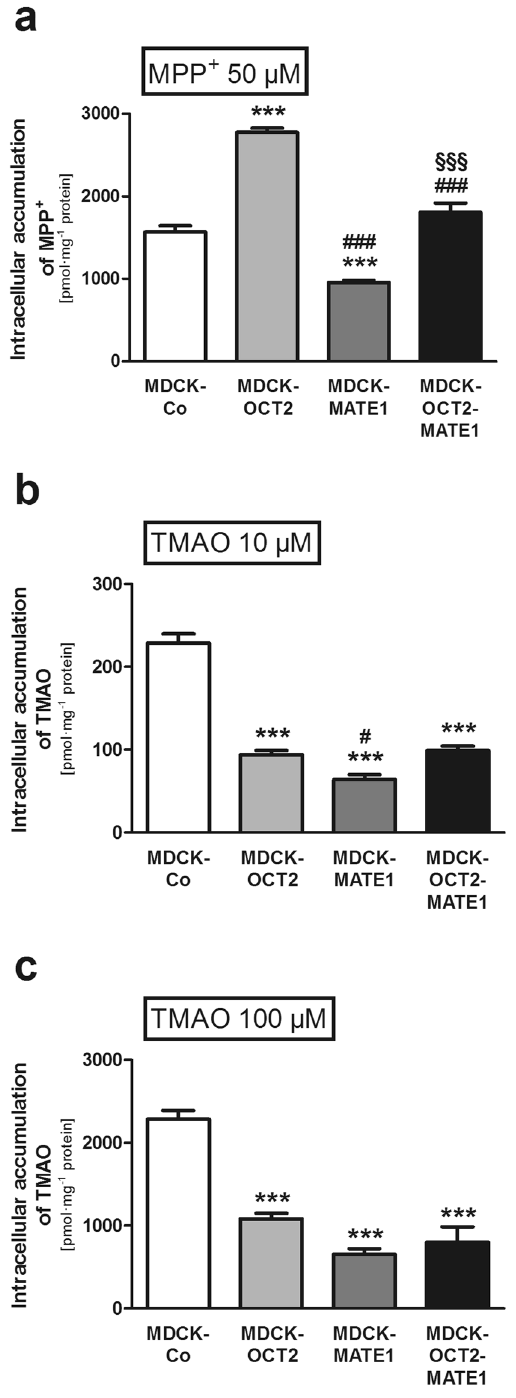
Figure 4. Intracellular accumulation of MPP + and TMAO [MPP + (50 µ M) ( a ), TMAO (10 µ M) ( b ), and TMAO (100 µ M) ( c )] in MDCK cells grown as polarised monolayers expressing OCT2 (MDCK-OCT2), MATE1 (MDCK-MATE1), or both OCT2 and MATE1 (MDCK-OCT2-MATE1) and control cells (MDCK-Co) after 60 min. Each data point is 2 × n = 3, mean ± SEM, *** p < 0.001 vs. MDCK-Co, # p < 0.05 vs. MDCK-OCT2, ### p < 0.001 vs. MDCK-OCT2, §§§ p < 0.001 vs.